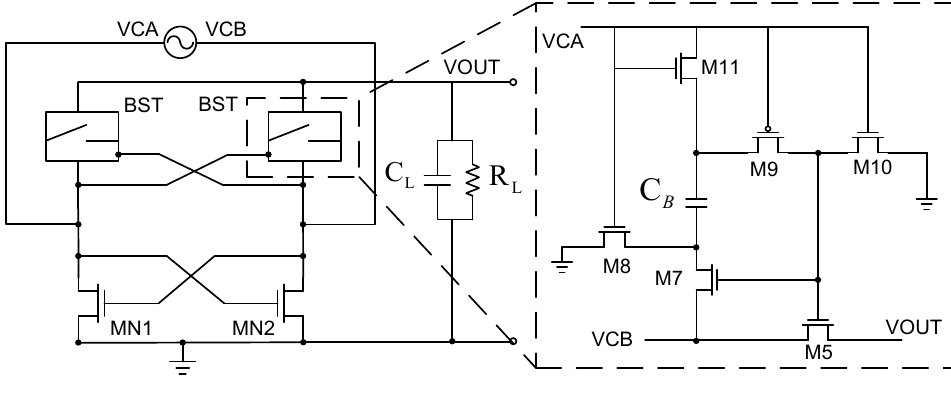
Figure 3. Bootstrap active rectifier circuit [8].